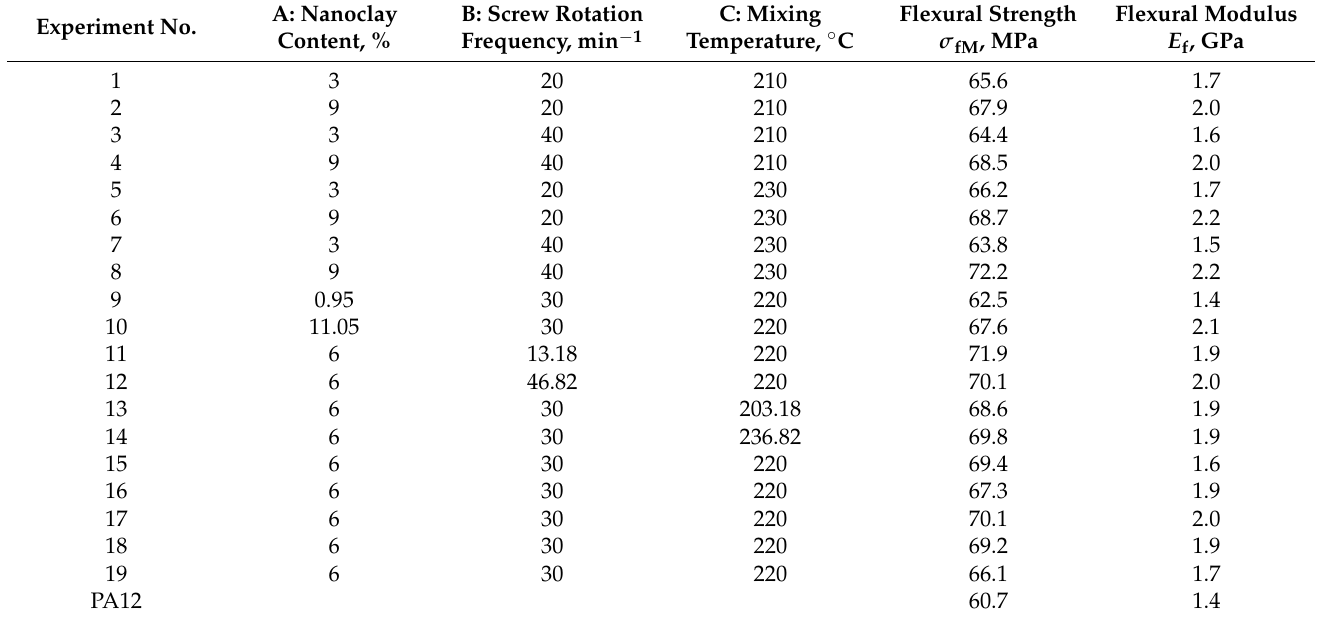
Table 3. Test results of flexural strength and flexural modulus for all